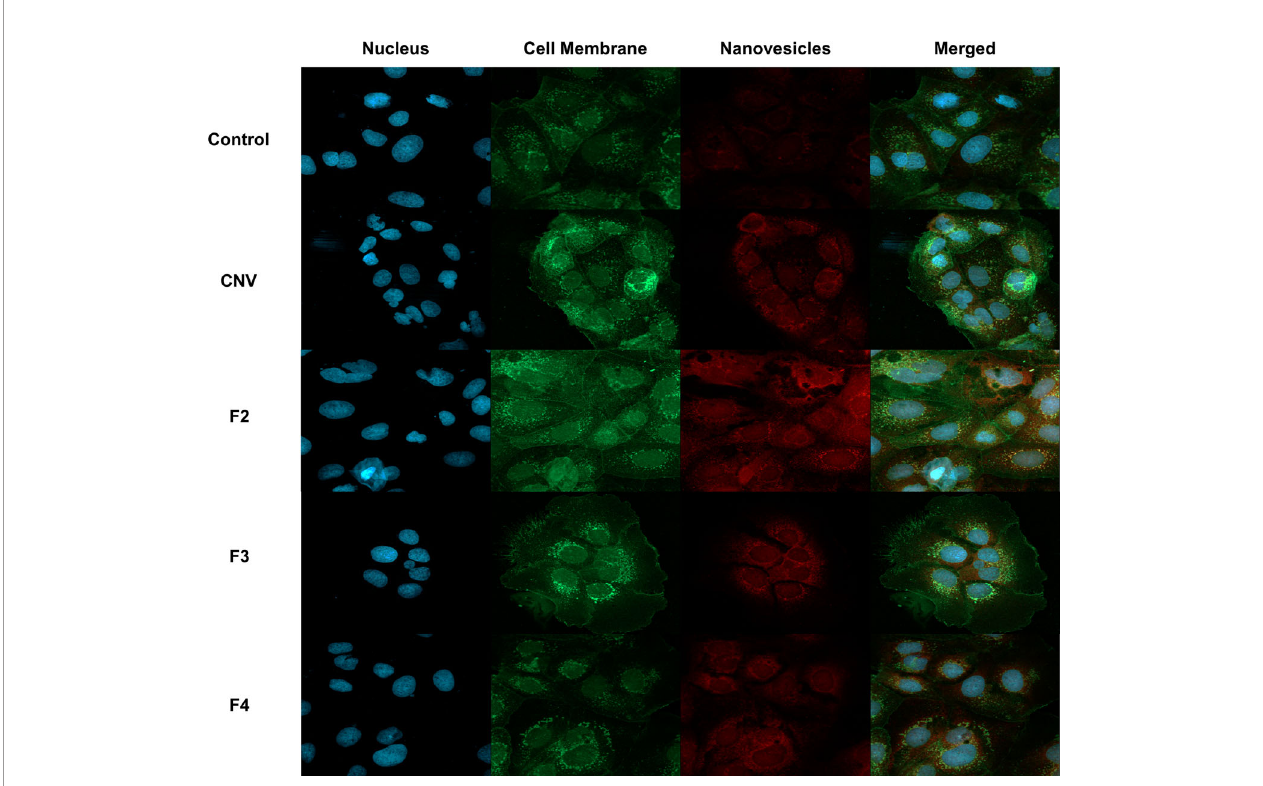
FIGURE 7 | Immuno fl uorescence of NV associated protein Sdp_SH3b2 in Caco-2 Cells. From top to bottom, control cells, crude NV (CNV), puri fi ed NV from fractions 3-5 (F2), puri fi ed NV from fractions 6-7 (F3) and puri fi ed NV from fractions 8-9 (F4). From left to right, DAPI to stain the nucleus, Alexa 488 to stain cell membrane, Texas Red conjugate to visualize NV through anti-Sdp_SH3b2, and the merged image at a magni fi cation of